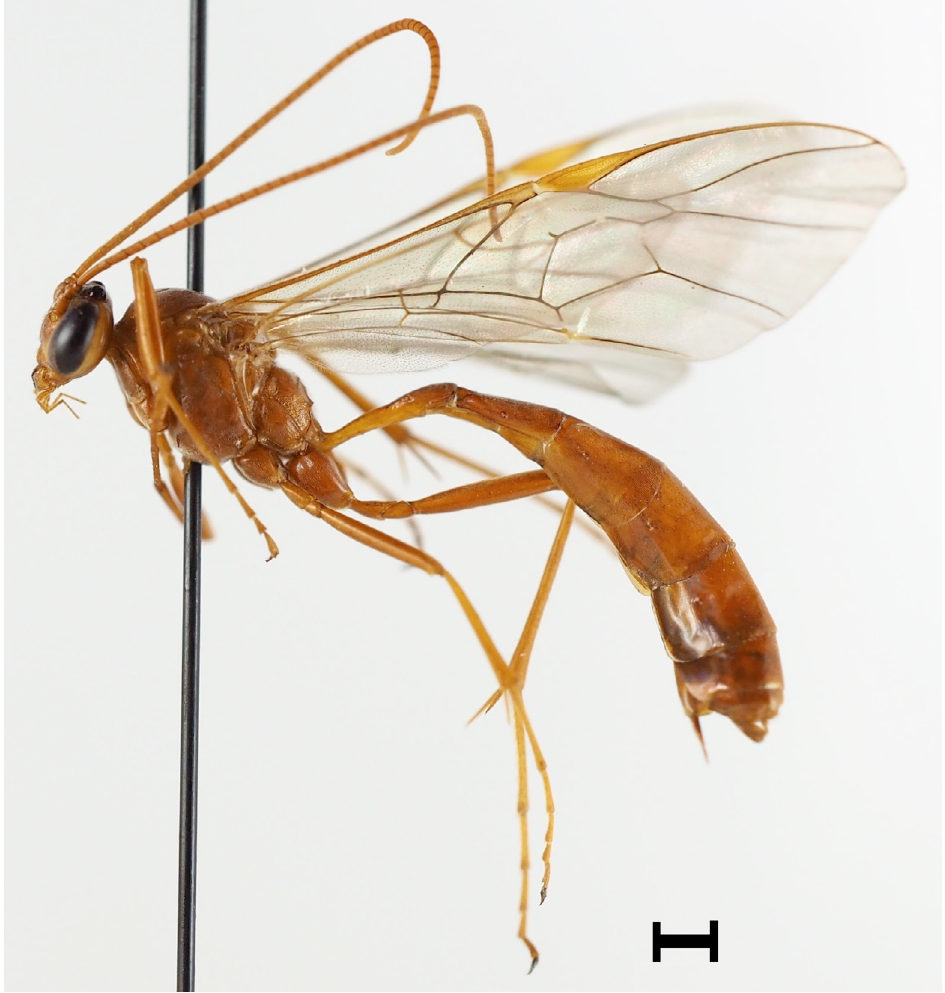
Fig. 37. Ophion norei Johansson sp. nov . , holotype, ♀ (NHRS-HEVA000008685). Scale bar = 1